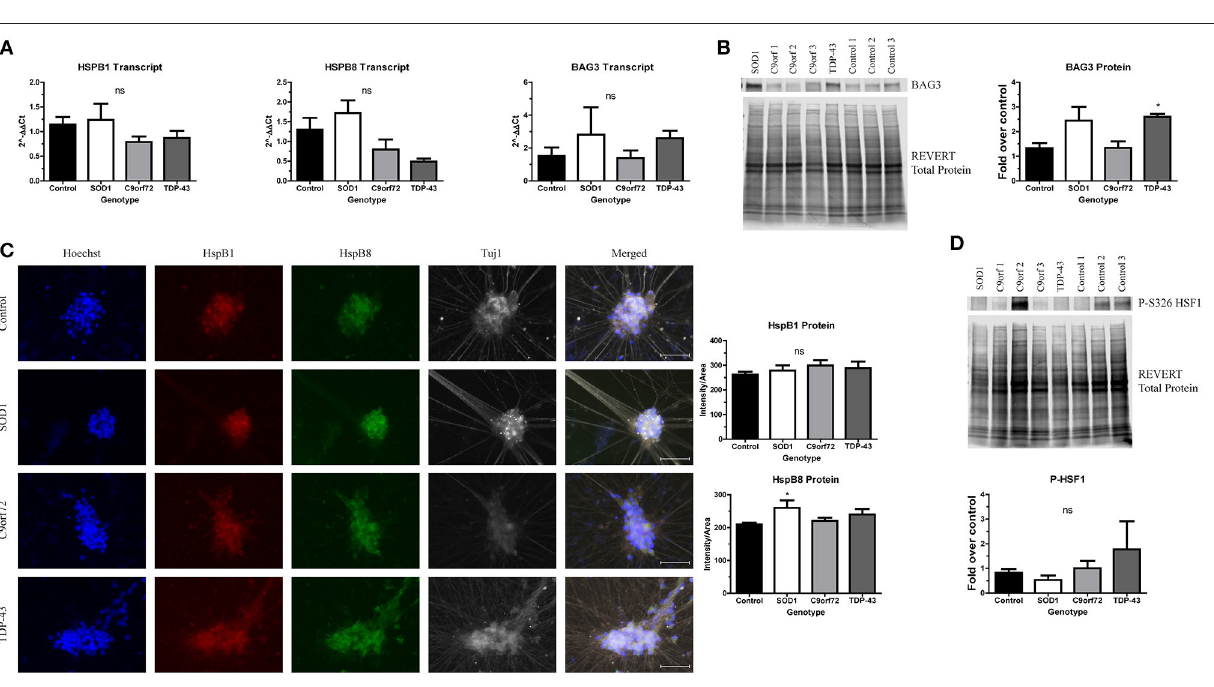
FIGURE 5 | ALS motor neurons have altered expression of HspB1, HspB8, and BAG3. (A) BAG3, HspB1, and HspB8 transcript levels are not significantly increased in ALS iPSC-derived motor neurons, n = 3–6. (B) Western blot for BAG3 shows an increase in TDP-43 motor neurons. Data are normalized to REVERT total protein and expressed as a fold change over control (* p < 0.05 by one-way ANOVA with Bonferroni post-hoc test, n = 3). (C) Quantification of HspB1 (green) and HspB8 (red) immunocytochemistry intensity shows a significant increase in protein levels of HspB8 in SOD1 motor neurons (* p < 0.05 by one-way ANOVA with Tukey post-hoc test, n = 3). Scale bar = 50 µ m. (D) Western blot for phosphorylated HSF1 at S326 shows no significant HSR induction in ALS motor neurons. Data are normalized to REVERT total protein and expressed as a fold change over control (ns, p > 0.05 by one-way ANOVA with Tukey post-hoc test). n =